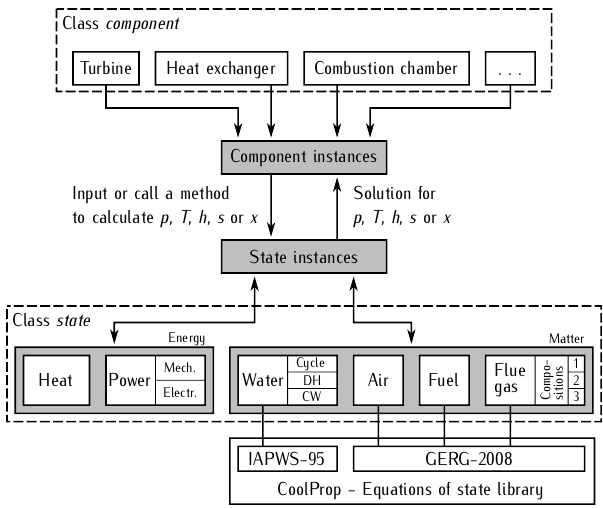
Figure 2. Interaction between instances of state and component